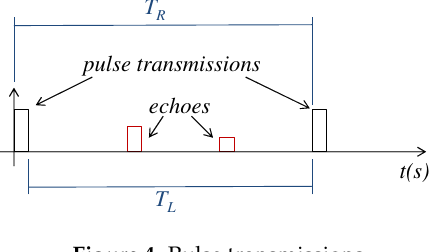
Figure 4. Pulse transmissions.